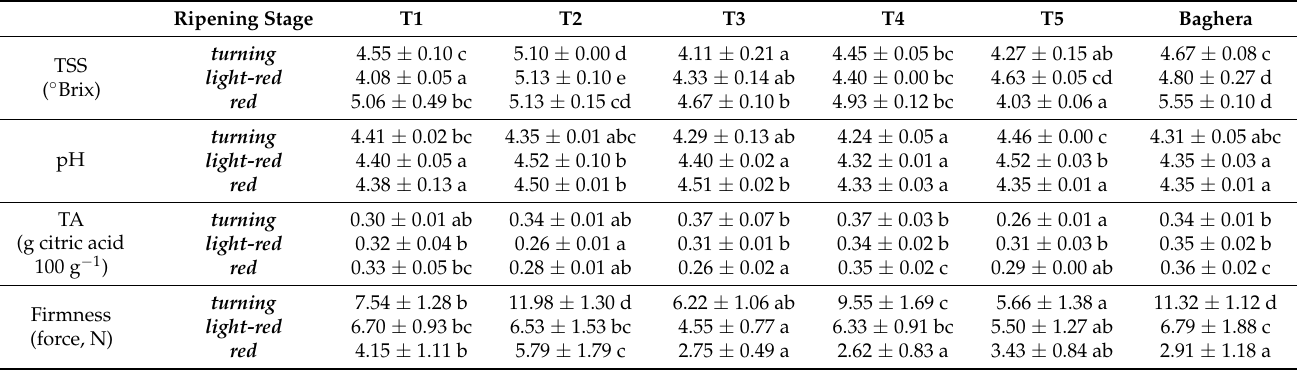
Table 2. Tomato quality parameters: TSS, pH, tritatable acidity and firmness.